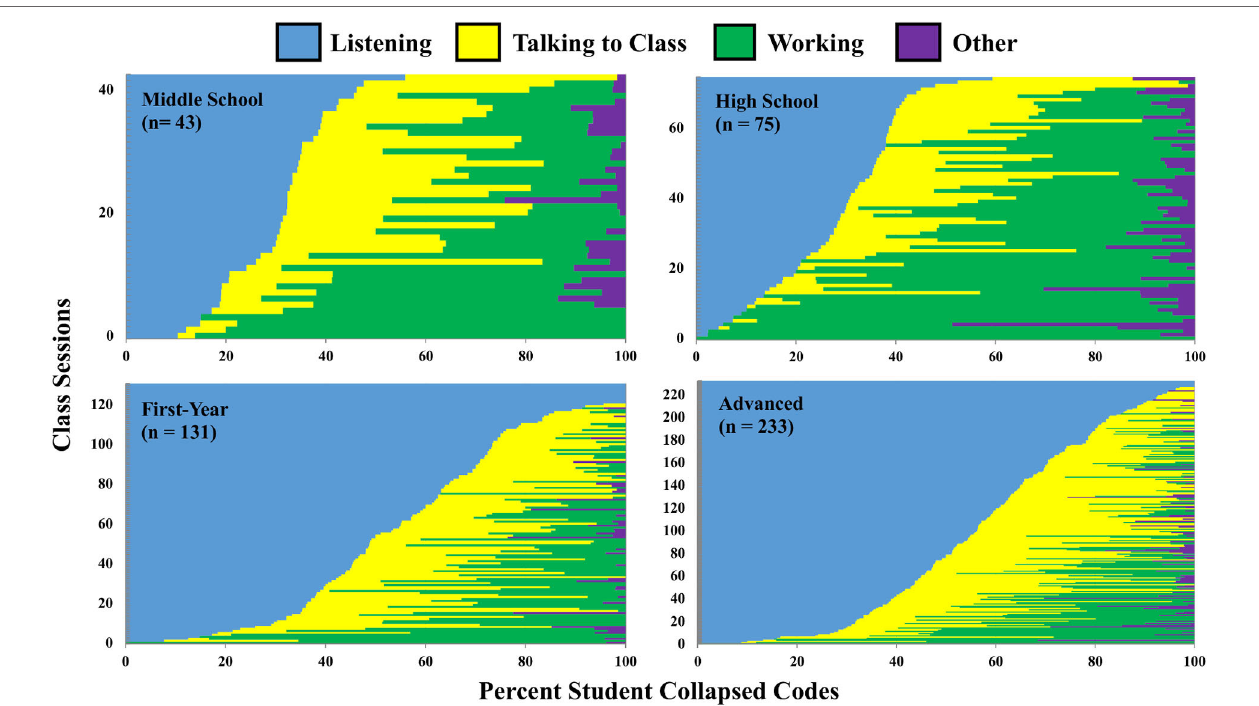
FigUre 6 | Percentage of student collapsed Classroom Observation Protocol for Undergraduate STEM codes for middle school, high school, first-year, and advanced university classes. Each horizontal bar represents a different class session. The classes are ordered by the collapsed code Student Receiving. Figure 1 describes the Student Collapsed Codes.